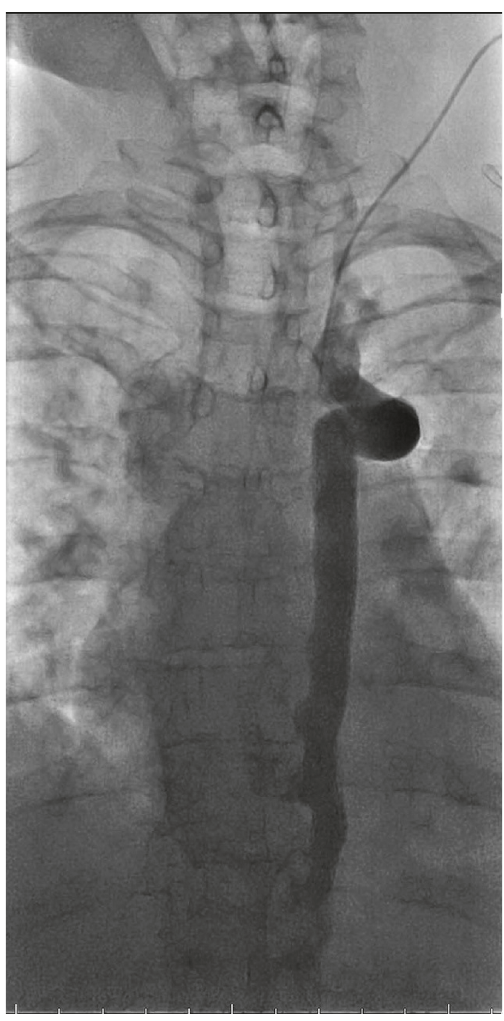
Figure 2: Left internal jugular venogram (early phase) demonstrat- ing persistent left superior vena cava (PLSVC) with continuation into the hemiazygos